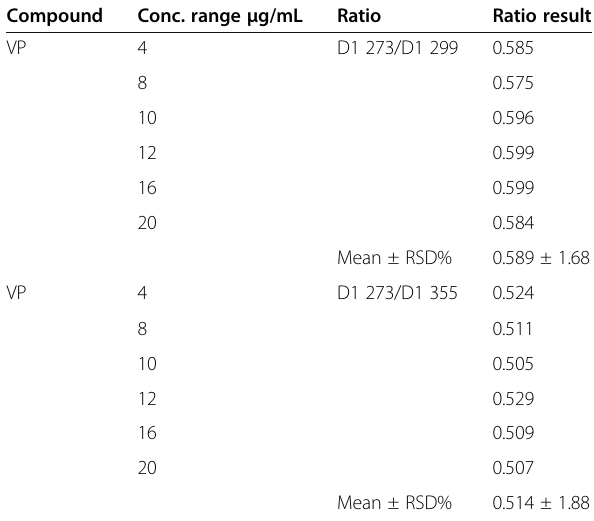
Table 1 Ratios of the derivative modes at the specified wavelengths for VP Compound